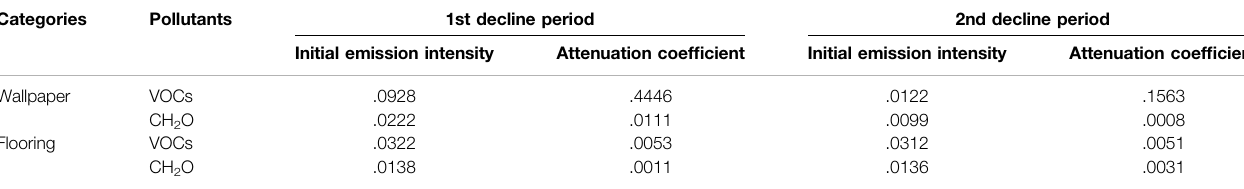
TABLE 7 | Variables related to Predicting the Emission